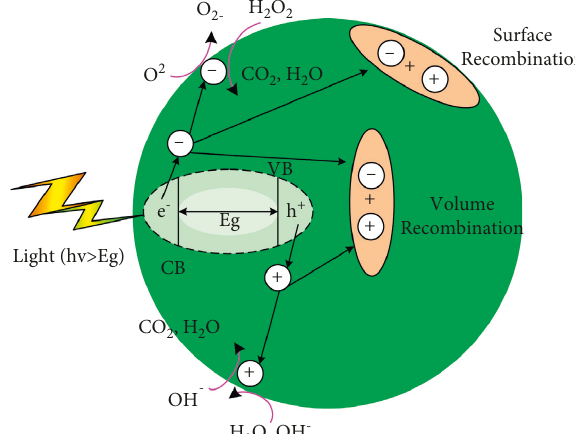
Figure 3: Principle of photocatalytic